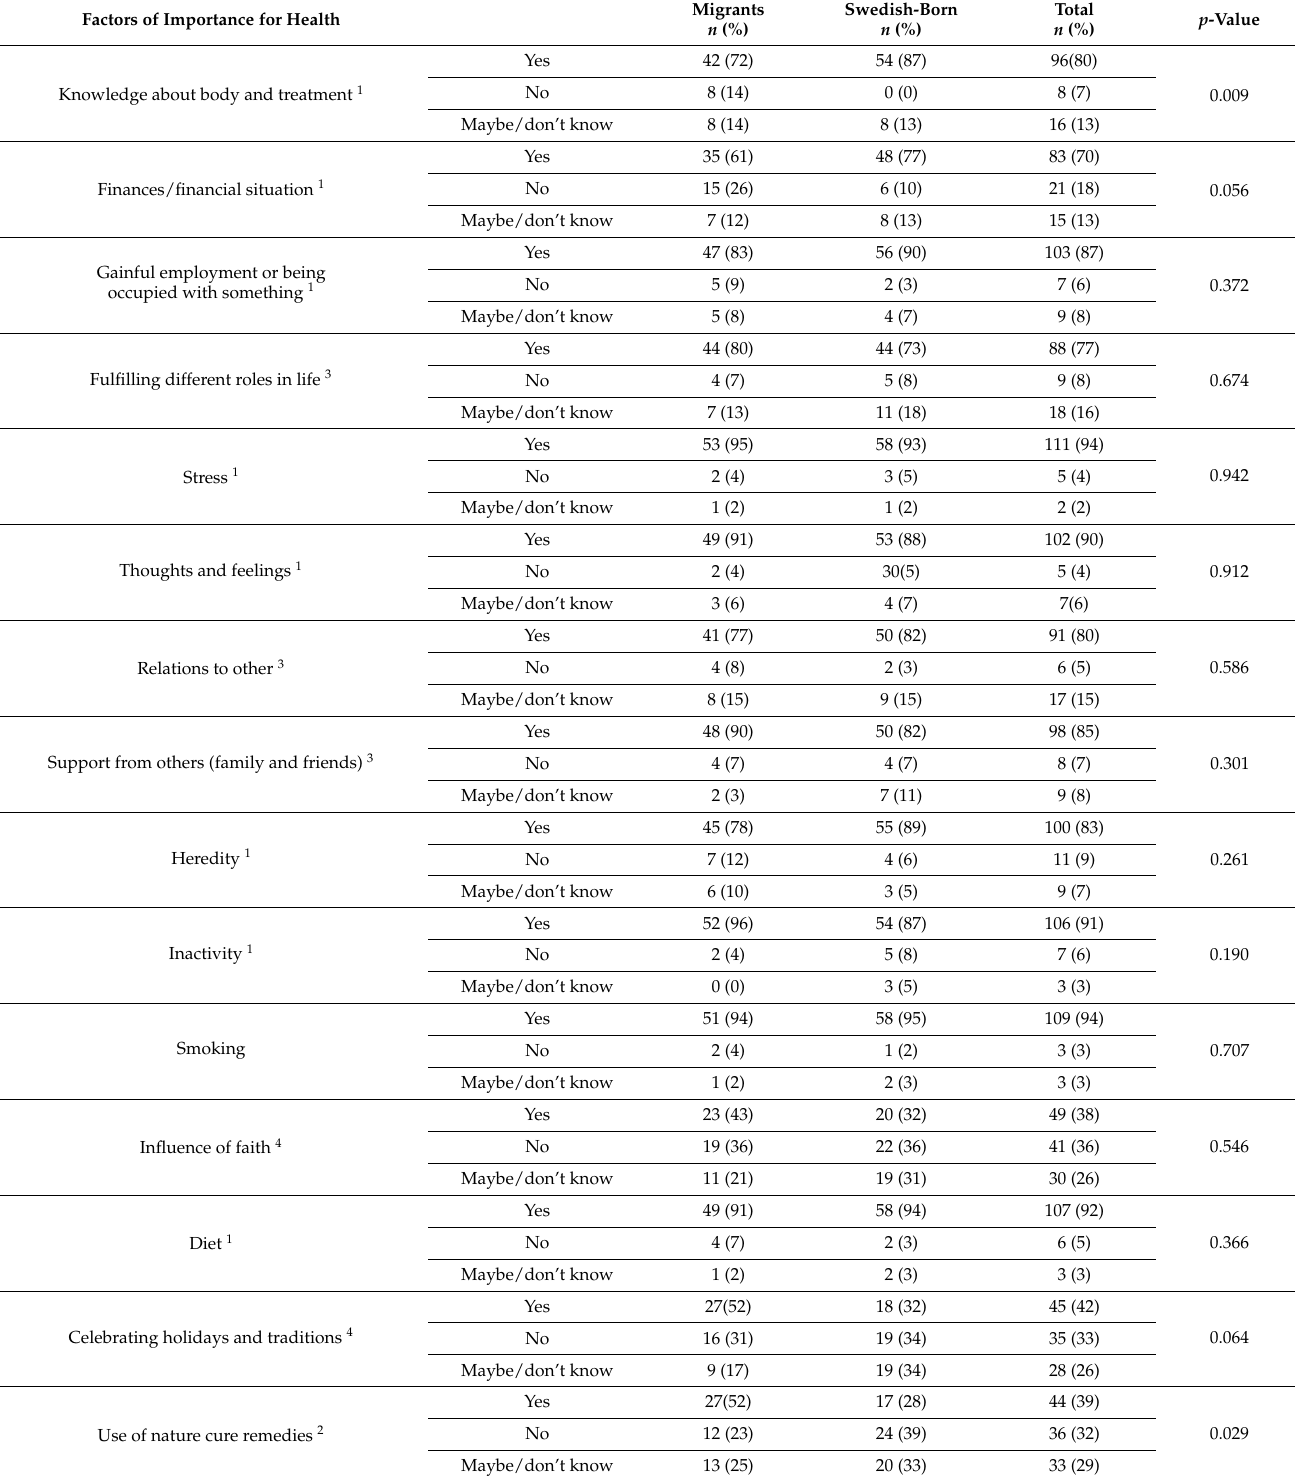
Table 5. Beliefs about factors of importance for health among migrants and Swedish-born persons with type 2 diabetes living in